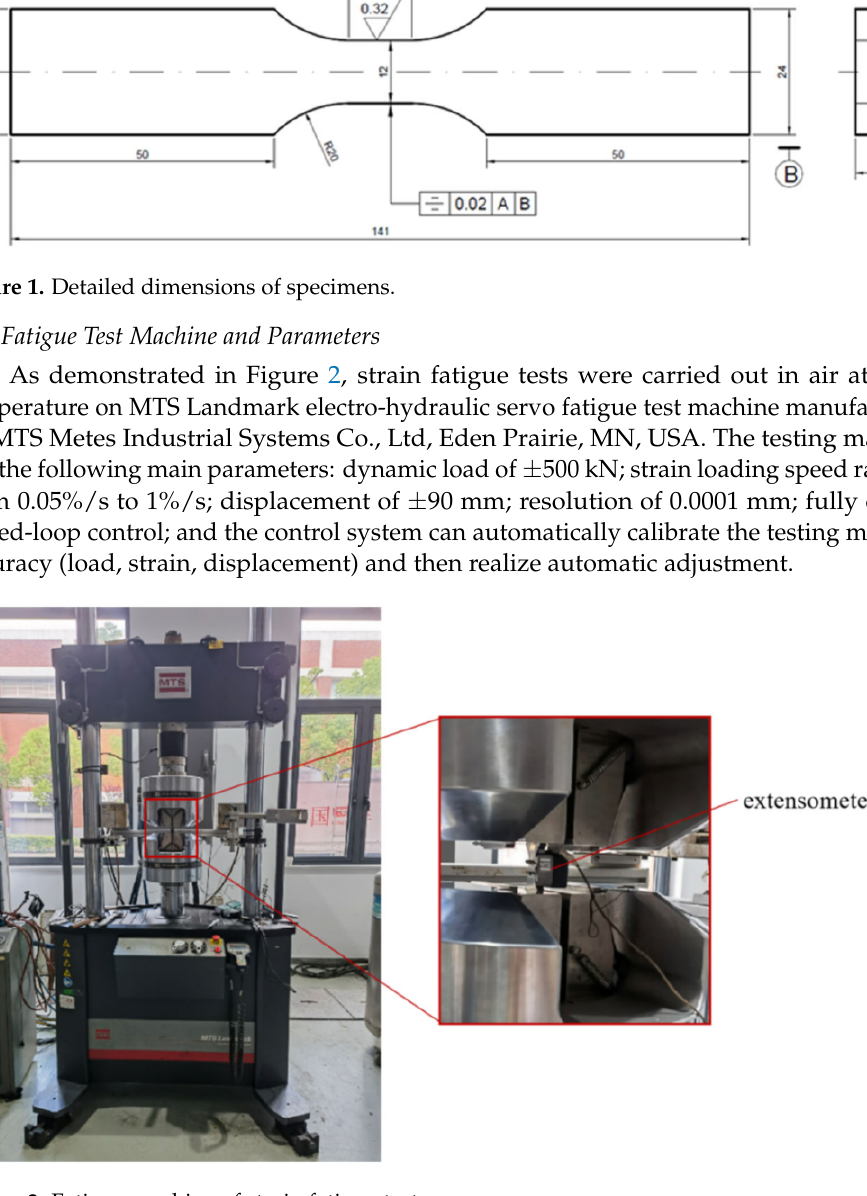
Figure 2. Fatigue machine of strain fatigue